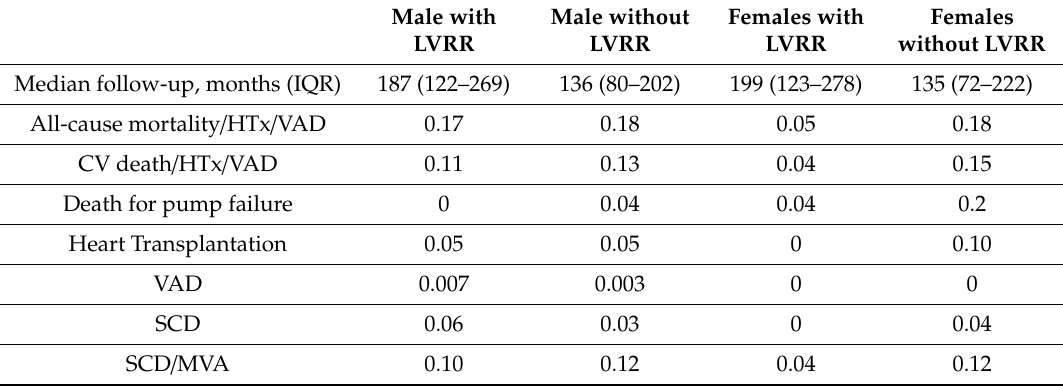
Figure 2. Kaplan-Meier curves for the incidence of All-cause mortality / HTx / VAD (Left Panel) and cumulative incidence function for SCD / MVA (Right Panel) according to LVRR and sex. Legend. HTx: Heart Transplantation; LVRR: Left Ventricular Reverse Remodelling; VAD: Ventricular Assist Device. MVA: Major Ventricular Arrhythmias; SCD Sudden Cardiac Death. Table 2. Cumulative incidence of events at 10 years of follow-up (starting from the 24 months evaluation) according to sex and